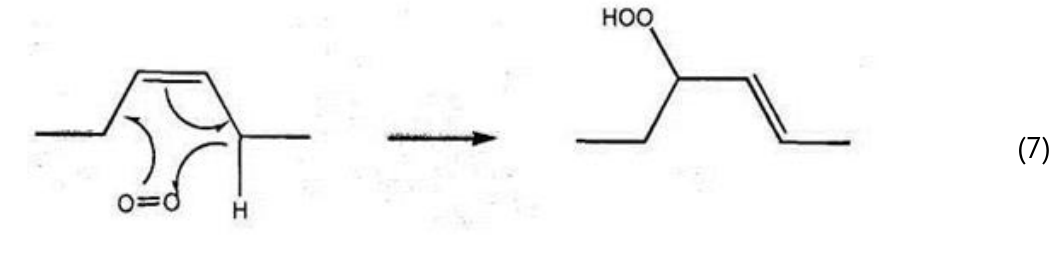
Figure 2. The mechanism of addition of singlet oxygen to the double bond